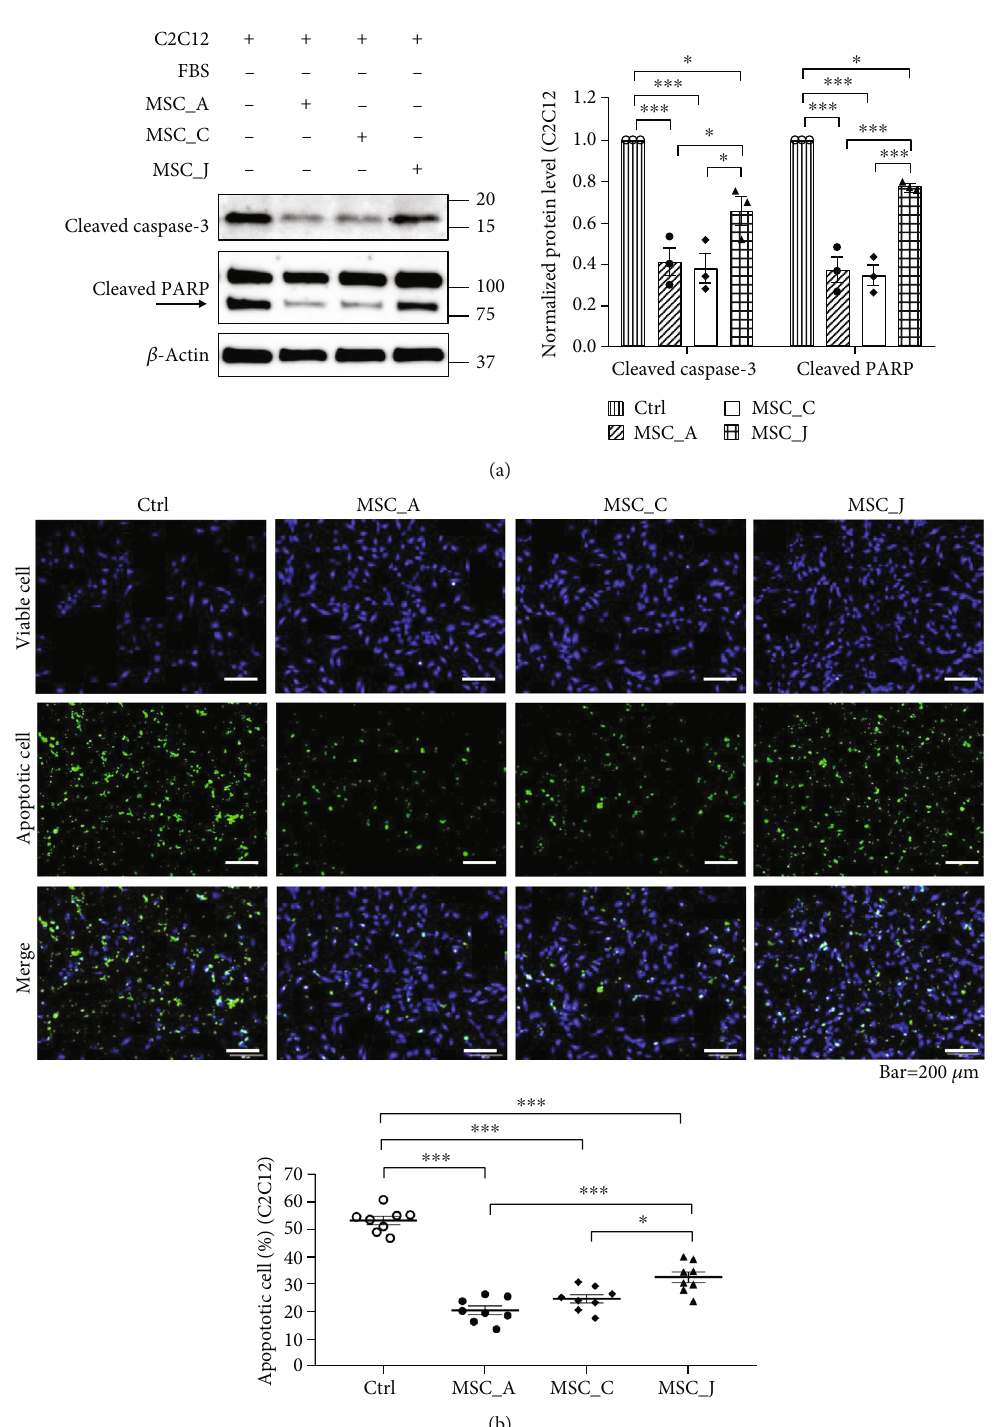
Figure 4: WJ-MSCs with high expression of AURKA and DOCK2 were more e ff ective in reducing apoptosis of mouse skeletal myoblast cells (C2C12). (a) Inhibition of apoptosis was evaluated by protein expression levels of cleaved caspase-3 and cleaved PARP in apoptosis- induced C2C12 cells after coculture with WJ-MSCs. Normalized protein level indicates the value converted based on that of the control group. (b) Representative fl uorescence images showed antiapoptotic e ff ect of WJ-MSCs in apoptosis-induced C2C12 (green, apoptotic cells; blue, viable cells). The chart quanti fi ed the apoptotic cell rate of each group. Data are shown as means ± SEM . One-way ANOVA with Tukey ’ s multiple comparisons test. ∗∗∗ p < 0 : 001 , ∗∗ p < 0 : 01 , and ∗ p < 0 : 05